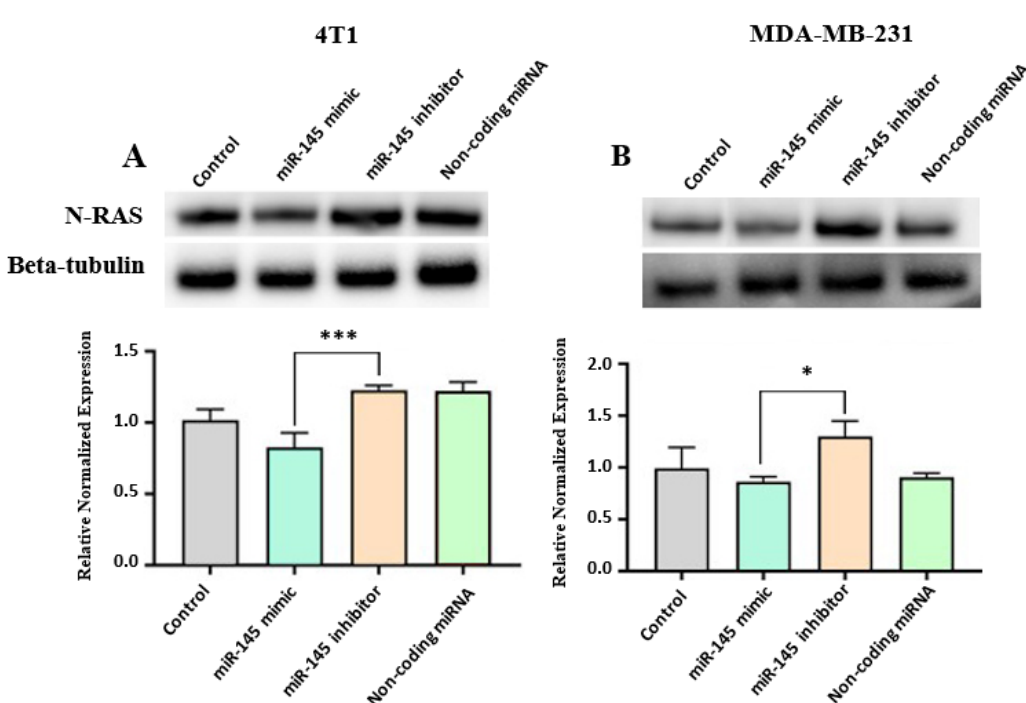
Figure 5. Relative expression of N-RAS in ( A ) 4T1 and ( B ) MDA-MB-231 cells transfected with a miR-145 mimic or inhibitor. The control consisted of using the same vehicle media used for treatment groups. Western blot images are from one representative experiment. One-way ANOVA and Bonferroni’s post-hoc tests were used to compare groups. All values are mean ± SEM of 3 separate experiments. * p < 0.05 and *** p < 0.001 miR-145 mimic vs. miR-145 inhibitor.